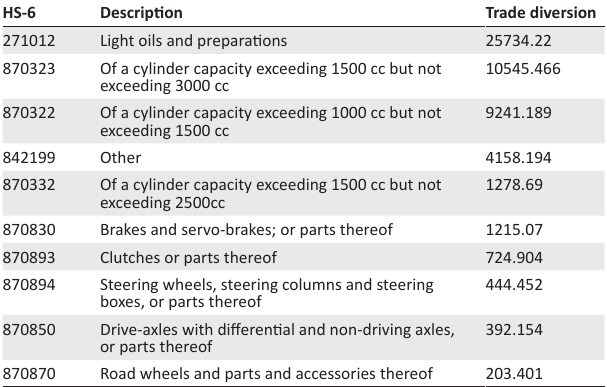
TABLE 4: Top 10 most vulnerable products to trade diversion (US$ 000).